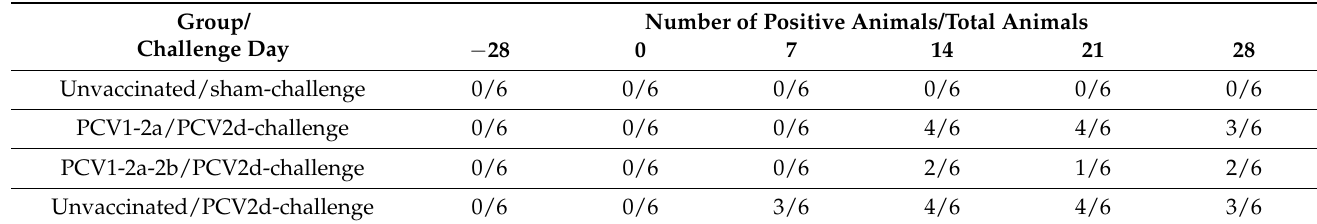
Table 2. PCV2 DNA detection in the serum